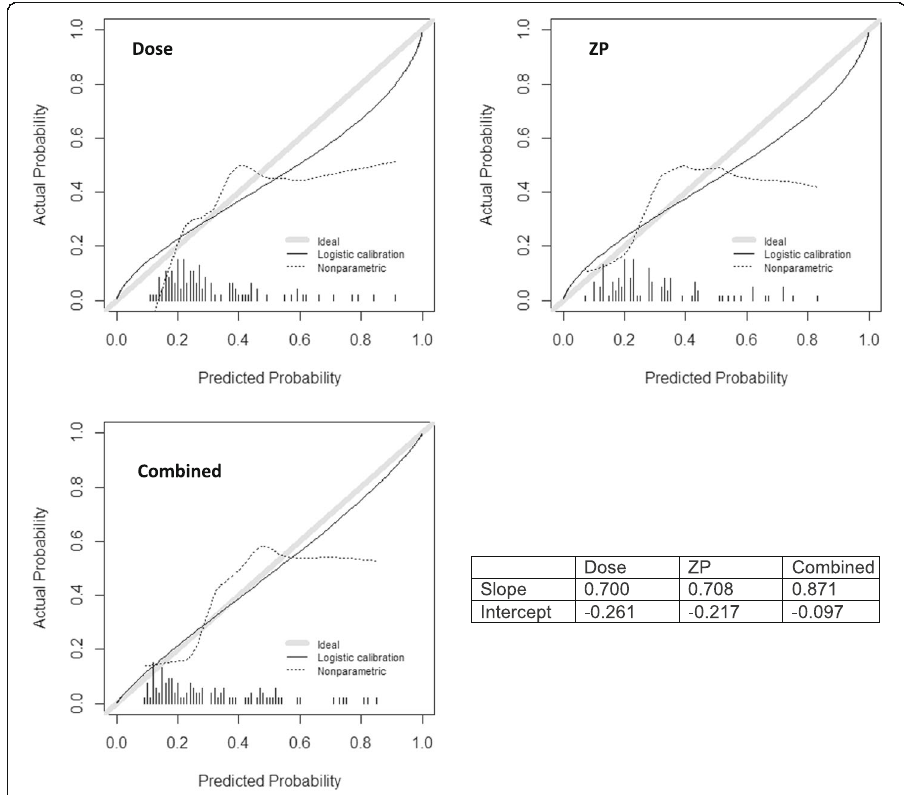
Fig. 6 Calibration curves for dose, radiomics, and combined models for OR endpoint, with the slopes and intercepts available in the